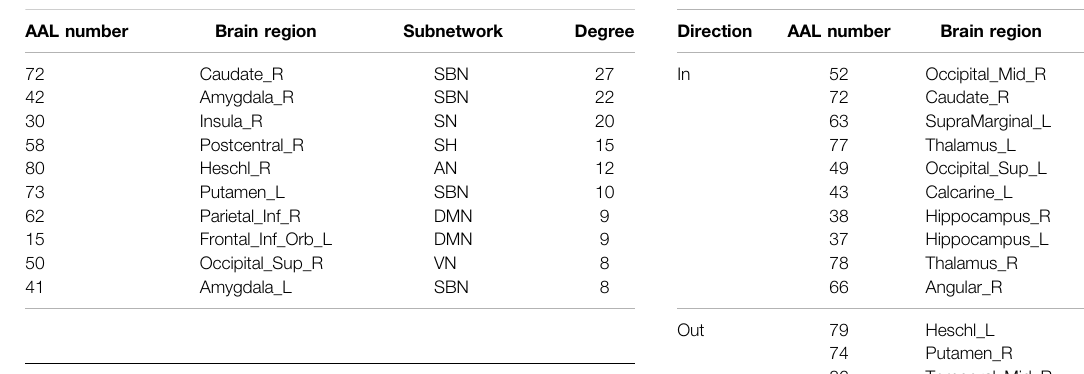
TABLE 7 | Top-10 brain regions corresponding to consensus degree based on the SR method.